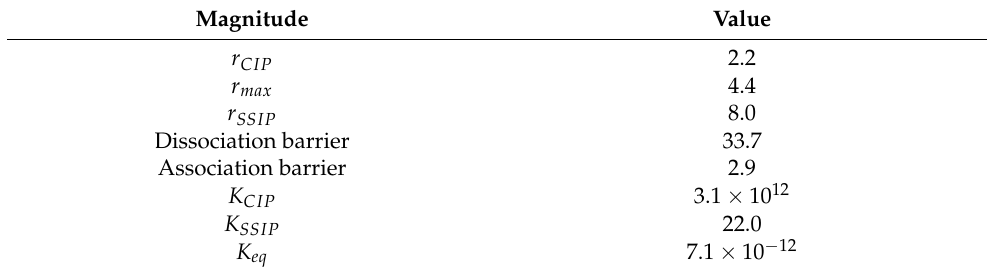
Figure 6. Configurations of acetonitrile clusters that illustrating the compositions of solvent molecules over ion pairs at various interionic separations. Li + (yellow color), Br − (green color), N (blue color) and C and Me (gray color). Table 6. Li + -Br − association-dissociation barrier heights in k B T and association constants in 1/mol (ion–ion distances are in